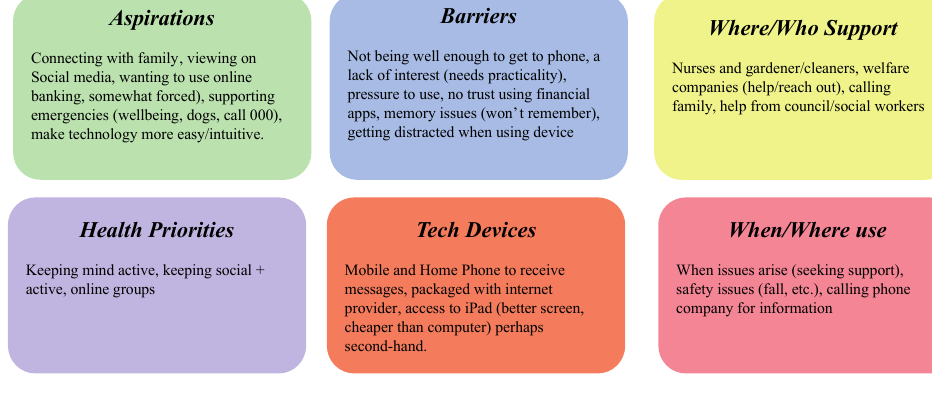
Figure 8. Low-literacy persona.